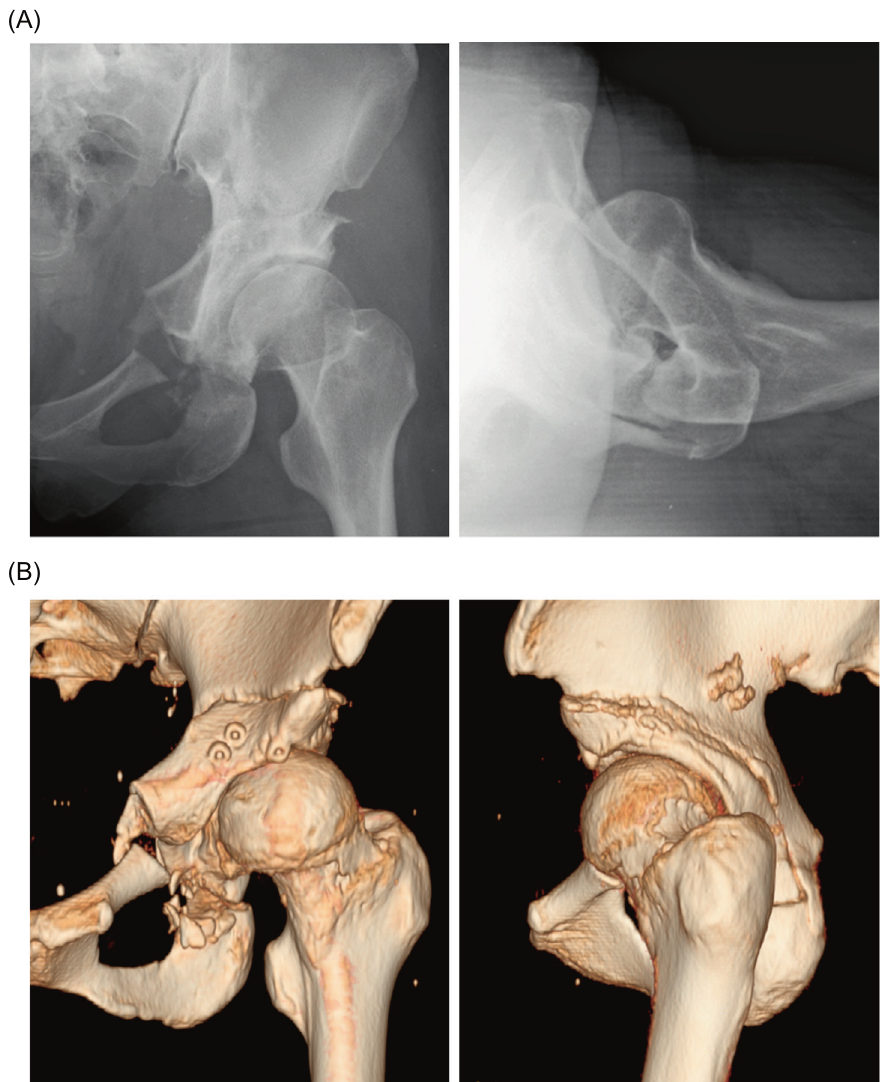
Figure 3. Post-operative radiograph following periacetabular osteotomy, which was aided by simulation with a three-dimensional (3D) salt-based model (A); post-operative 3D reconstruction computed tomography image clearly reflecting the pre-operative simulation